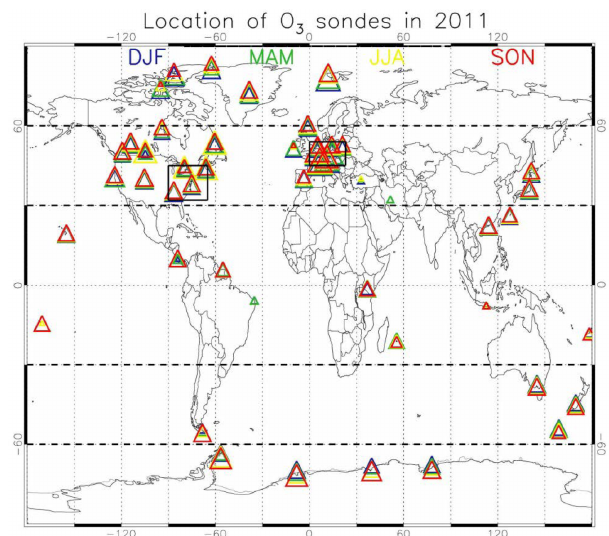
Figure 2. Geographical distribution of the ozone-sondes dur- ing 2011 used for evaluation, coloured for the various seasons. The size of the triangles provides information on the relative number of observations available for each of the seasons and locations com- pared to the other locations. The geographical aggregation for the five latitude bands presented in Figs. 5 and 7, as well as the western Europe and eastern US regions, is also